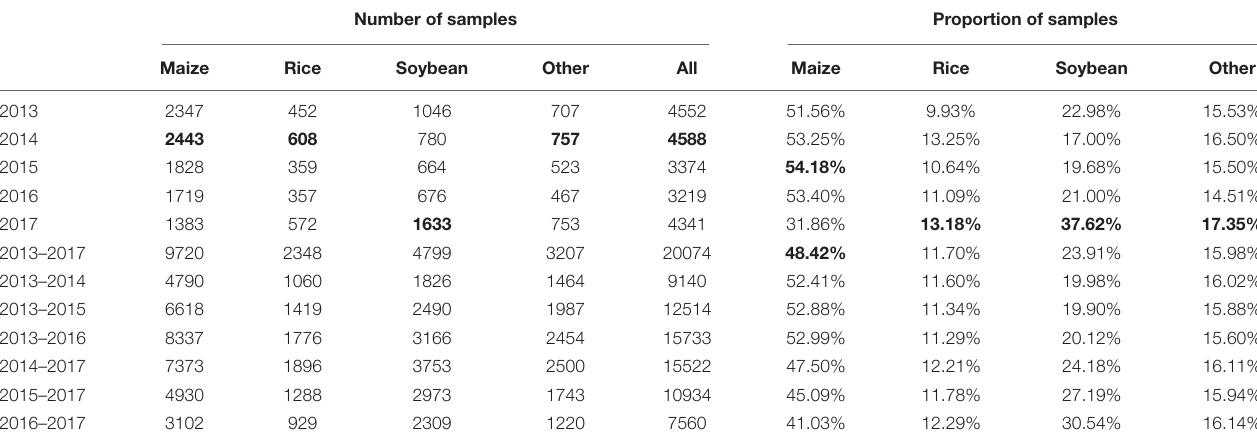
TABLE 2 | The number of new